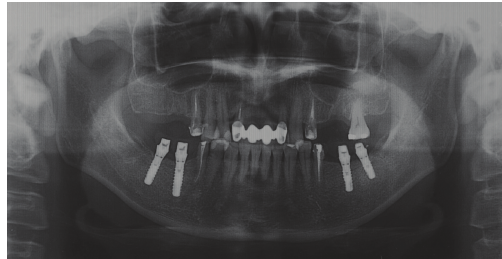
Figure 1: Panoramic radiograph shows a case of atypical odontalgia causing in a 57-year-old woman. The woman complained of toothache in the bilateral upper molars after the replacement of dental implant into the lower jaws. The root canal treatments of upper molars were performed, and the upper molars were finally extracted, since her pain was not relived by any treatments. A prescription of 40 mg per a day of amitriptyline decreased symptoms in the